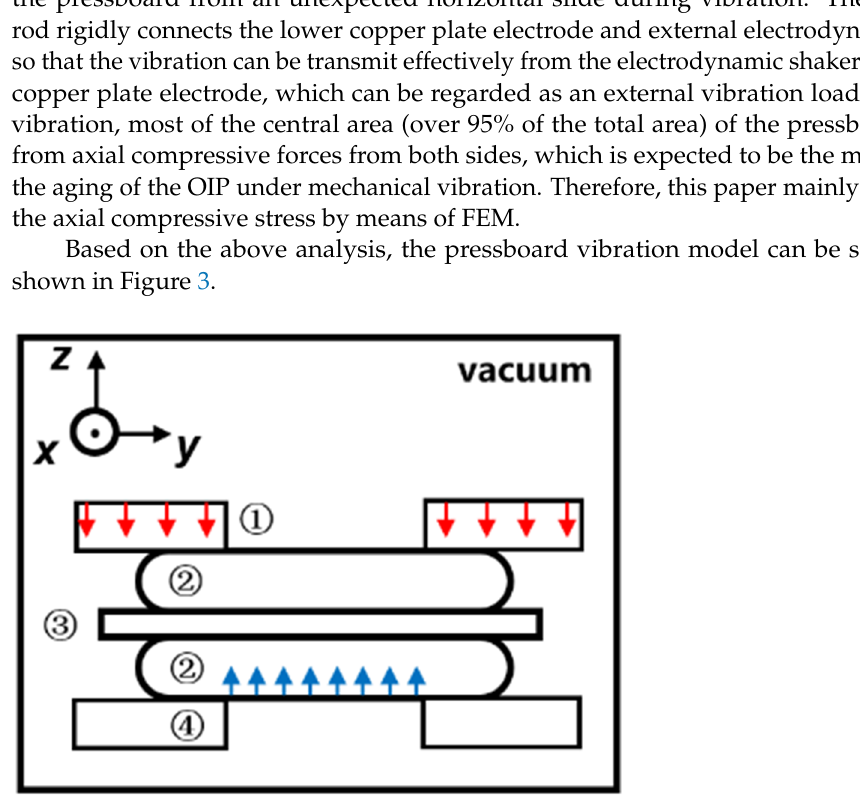
Figure 3. Pressboard vibration system in OIP multi-stress aging experimental setup ( ① mica board, ② copper electrode plate, ③ pressboard, ④ aluminum board, ↓ preload, ↑ vibration).